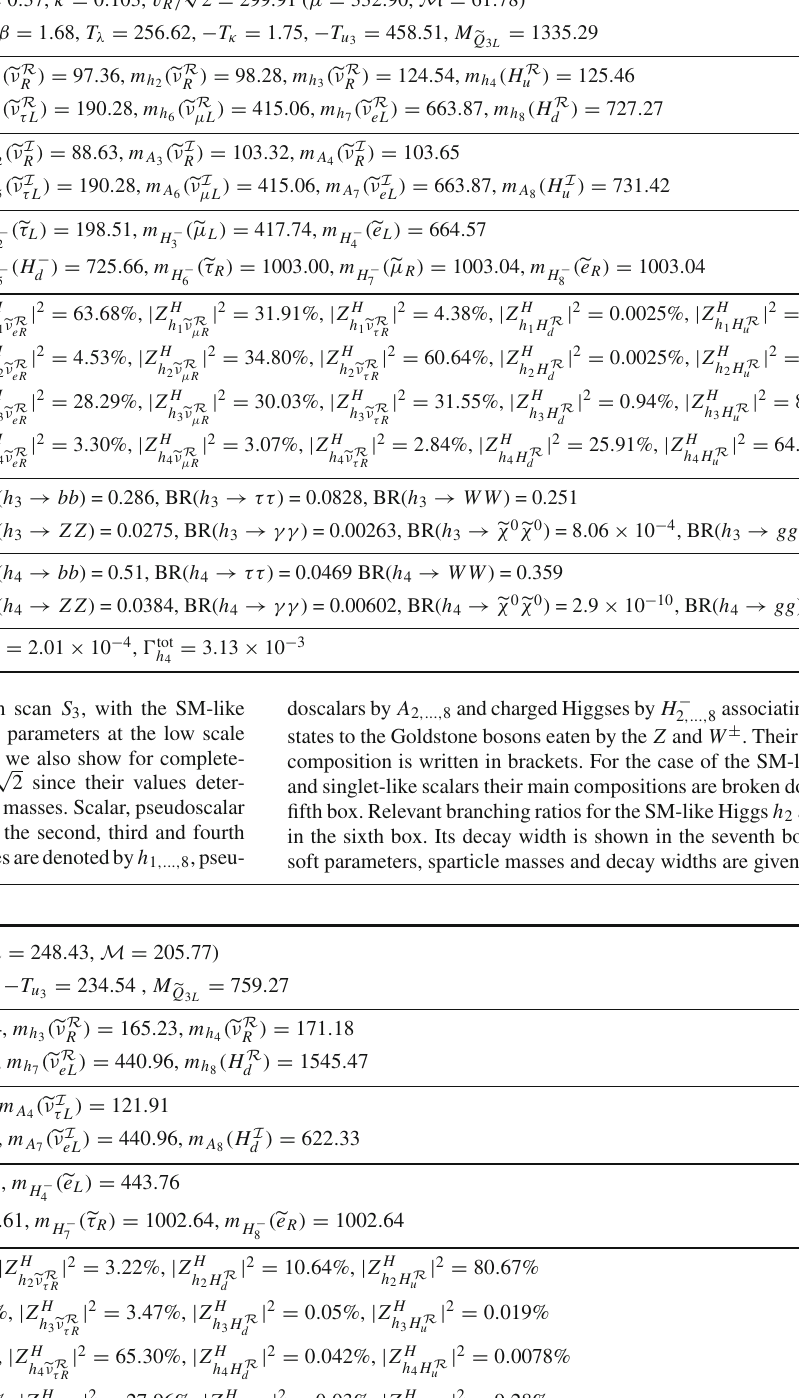
Table 11 The same as in Table 7, but for a benchmark point S2-2h2 with several singlet-like scalars h 1 , 2 , 3 of masses close to the mass of the SM-like Higgs h 4 . The branching ratios of h 4 , and h 3 which contributes significantly to the superposition of signals, are shown in the sixth and seventh boxes, and their decay widths in the eight box